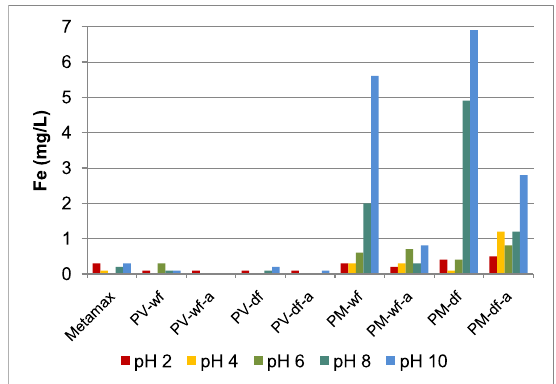
Figure 8. Leaching of iron at different pH values.